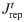
(a) Daily new SARS-CoV-2 infections reported in the early months of 2020 in Germany. The number of new reported infections per day Jrept (red symbols) is shown together with the number of reported infections per day for those cases with later fatal outcome Jrepf (blue symbols). (b) Semi logarithmic representation of the same data. The dashed and solid lines represent linear and cubic fits to the data in specific time intervals. They are used to estimate the initial and final growth rates λ0 and λ∞ as well as A2=J¨/J and A3=J⃛/J at the maximum of the rate of new cases Jmax. We find λ0 ≃ 0.269 day−1 (0.336 day−1), λ∞ ≃ −0.068 day−1 (−0.038 day−1), A2 ≃ −10−2 day−2 (−0.9110−2 day−2) and A3 ≃ 6.810−4 day−3 (7.510−4 day−3) for the fatal cases (for all reported cases).